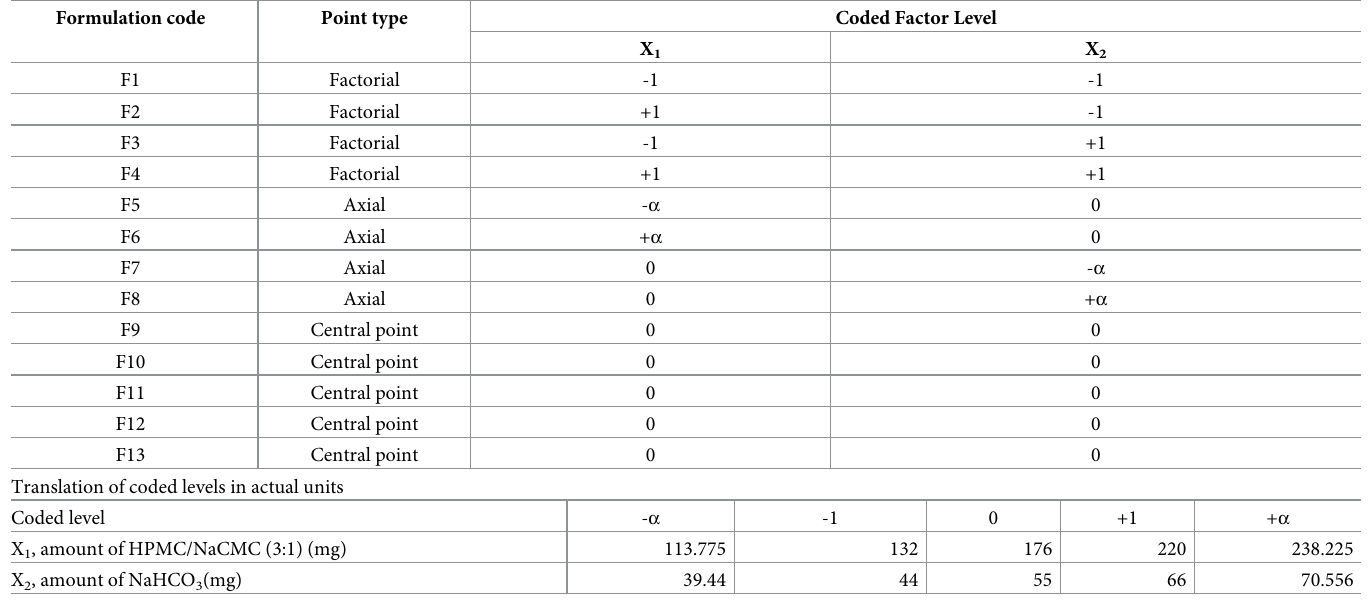
Table 1. Factor combination by CCD for formulation of ranitidine HCl (150mg) tablets.